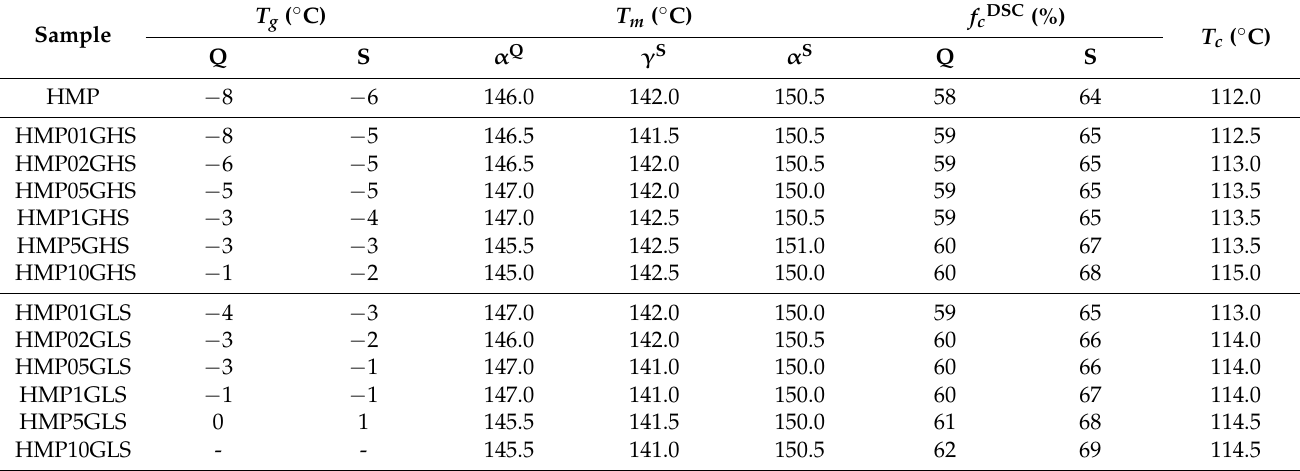
Table 2. Glass transition temperature ( T g ), melting temperature ( T m ), and total DSC crystallinity degree ( f cDSC ) calculated from the first melting run for the different nanocomposites processed under the two Q and S thermal treatments. Values of crystallization temperature ( T c ) in the subsequent cooling are also